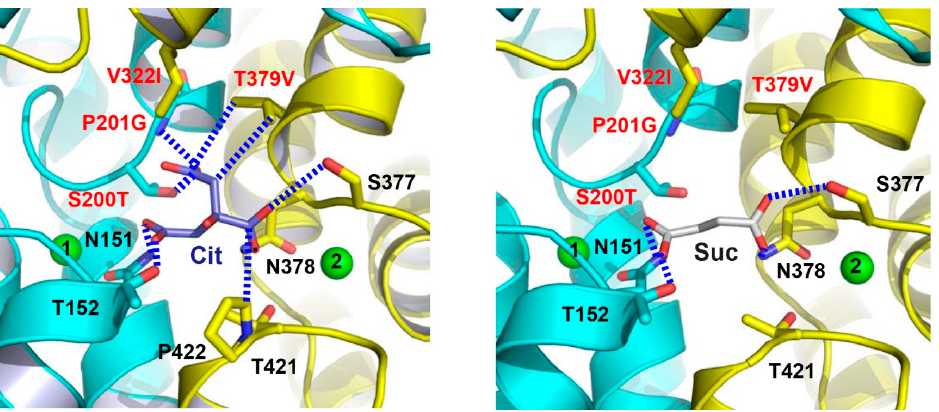
Figure 6. The citrate- and succinate-binding sites in humanized variant of VcINDY. Structure of the citrate-binding site ( left panel ). Close-up view of the succinate-binding site ( right panel ). Citrate (light blue), succinate (grey) and relevant amino acids are drawn as stick models, while the Na + ions are shown as green spheres. Humanizing amino-acid substitutions are highlighted in red. Dashed lines (blue) indicate the interactions between MT5 and citrate or succinate.